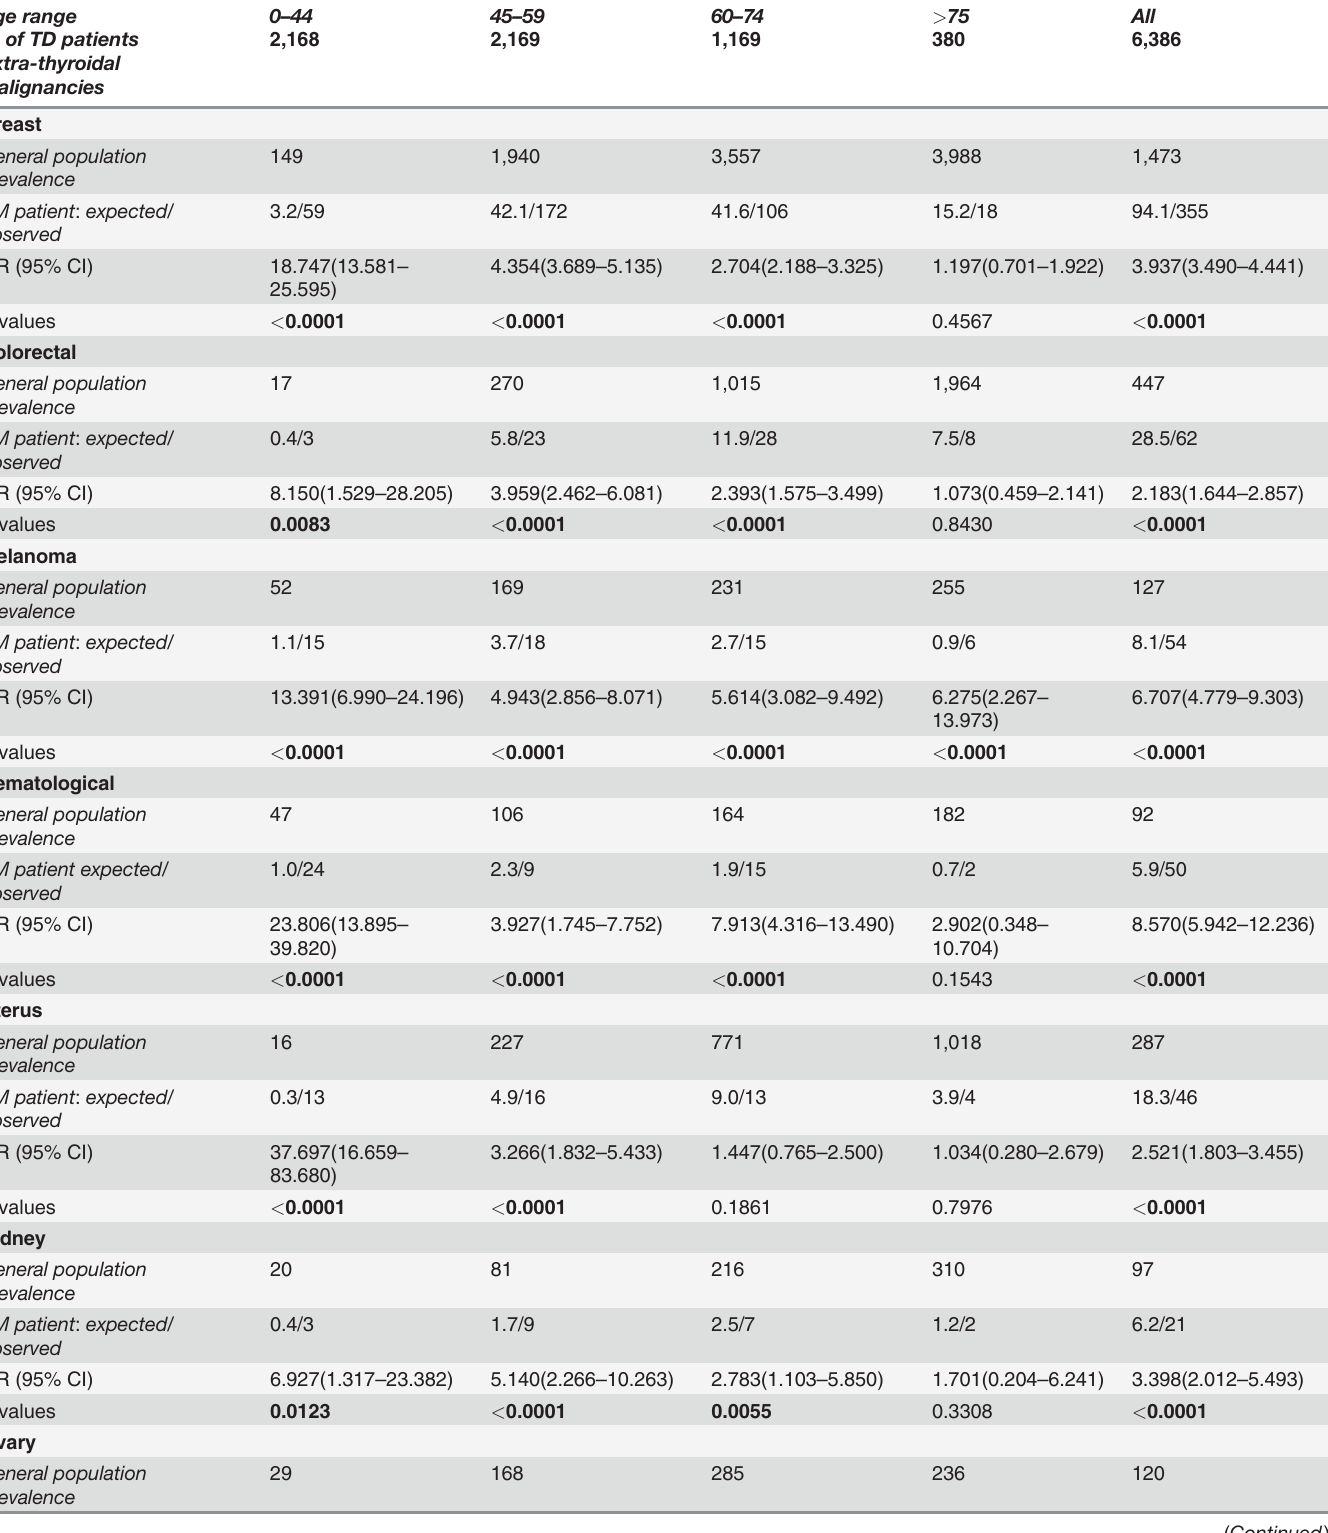
Table 1. Age and Extra-Thyroidal Malignancies in the 6,386 Female Patients Included in the